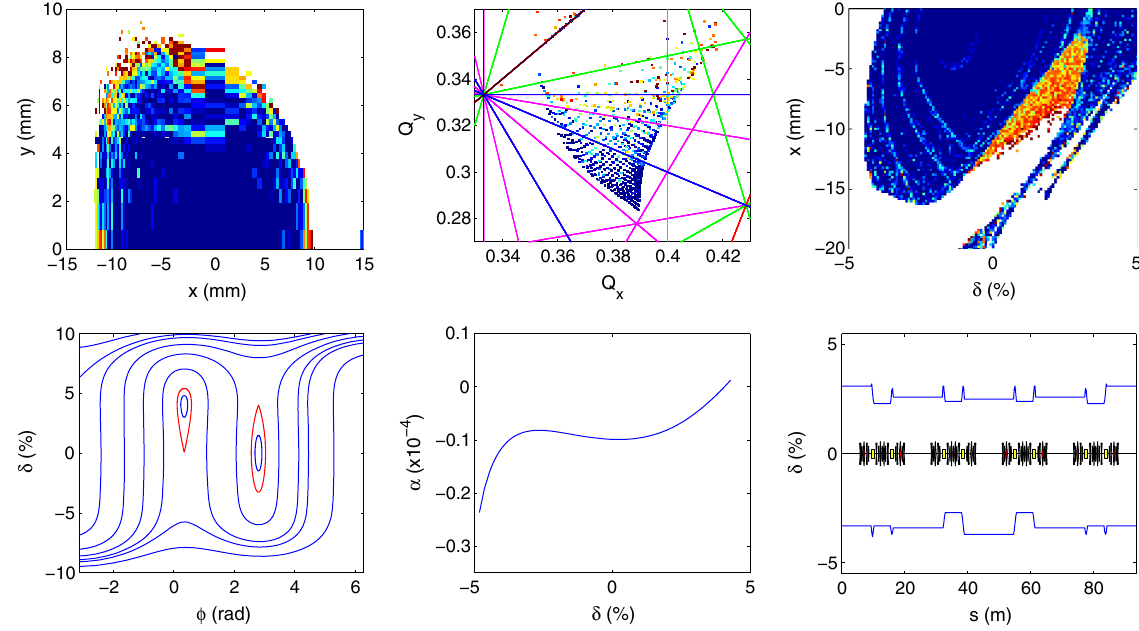
FIG. 4. On-momentum dynamic aperture (top left), frequency map (top middle), and off-momentum dynamic aperture (top right) for the low-emittance lattice. The longitudinal phase space (bottom left), momentum compaction factor (bottom middle), and momentum acceptance (bottom right) for one super period of the ring are also shown. The separatrices between stable and unstable motion are highlighted in